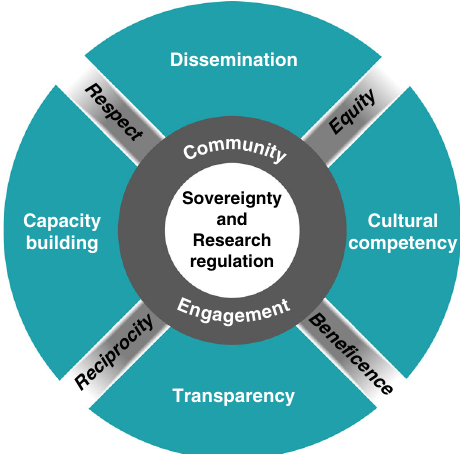
Fig. 1 An ethical framework for enhancing genomic research with Indigenous communities. The recognition of tribal sovereignty and research regulations are at the core of our ethical framework. Moving outward from the center, community engagement is necessary to build a foundation to create a collaborative partnership among researchers and community members. Starting from the right going clockwise, researchers should incorporate cultural competency, transparency, capacity building, and dissemination strategies to build trust, increase inclusion of diverse groups in genomic research, and enhance ethical research practices. The diagonal words represent core values that should be used throughout the research